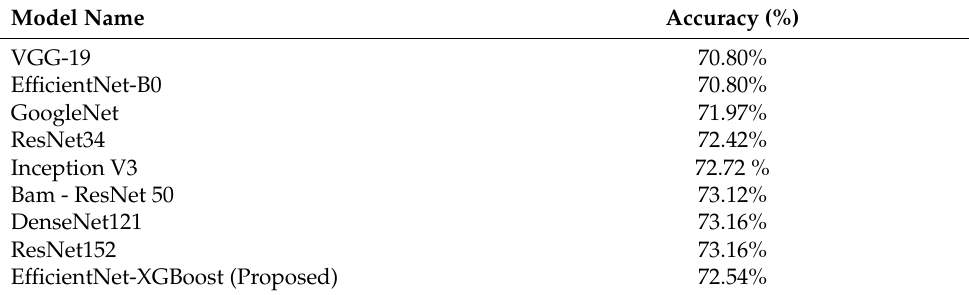
Table 10. Accuracy of FER2013